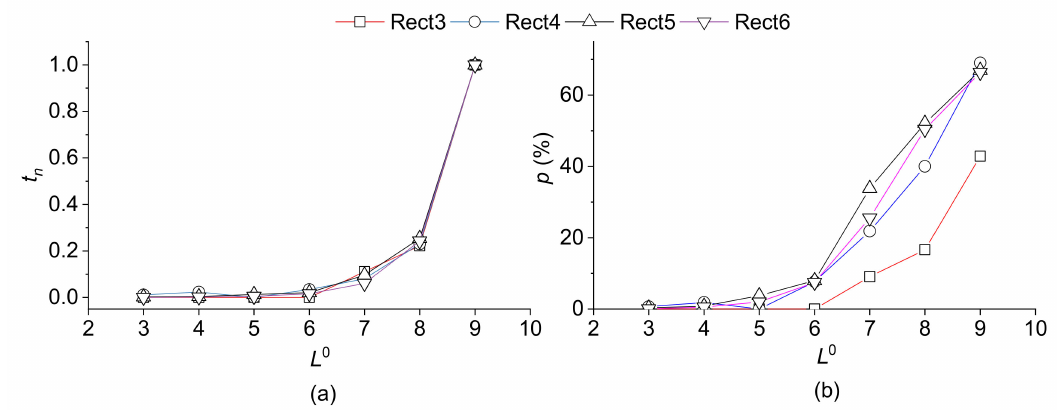
Figure 10. Time costs associated with auxiliary file location in different region queries as L 0 a increases. The first and second rectangles are excluded from this figure because their time costs are extremely small (Figure 7) and might easily be affected by the measurement error. ( a ) Normalized time cost ( t n ) obtained by dividing the maximal time cost that appears in each region query; ( b ) relative time cost determined according to the percentage ( p ) of the contribution of the auxiliary file location